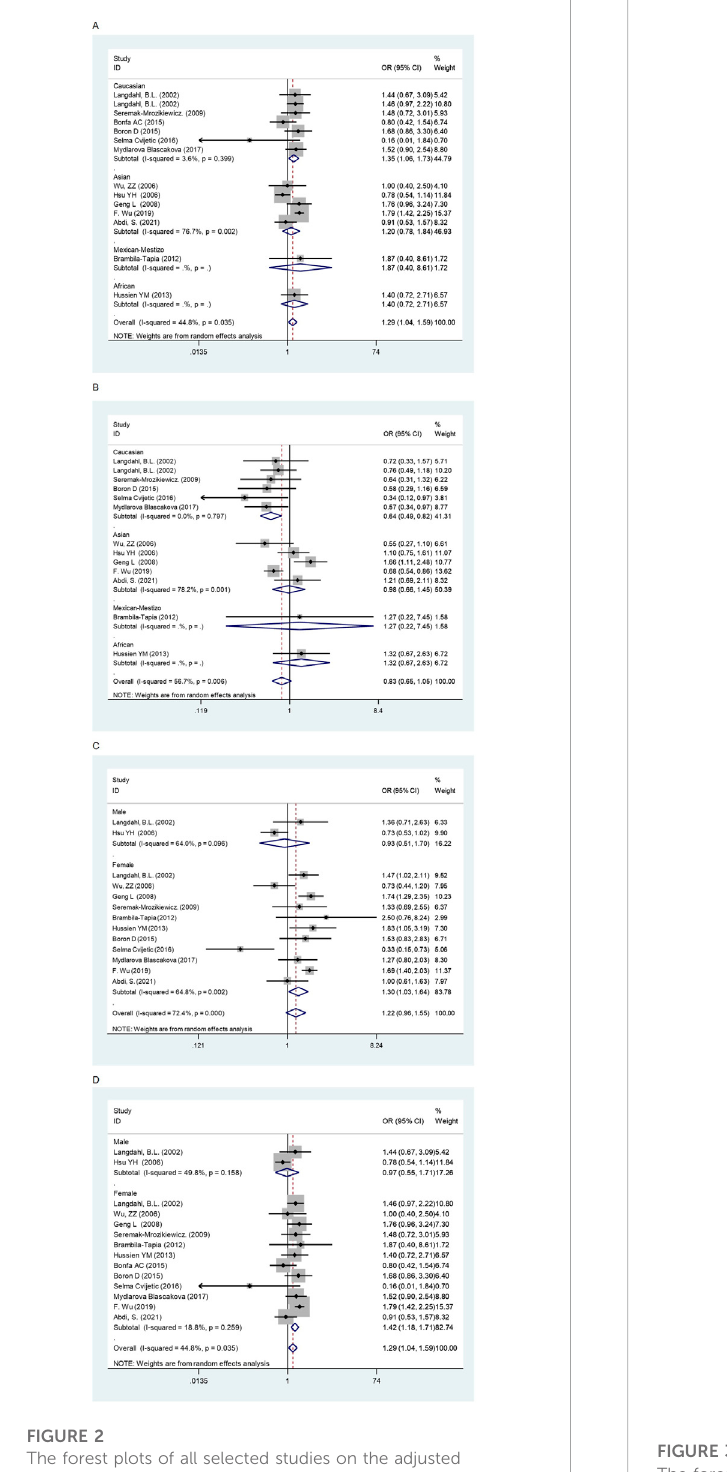
FIGURE 3 The forest plots of all selected studies on the adjusted association between the OPG G1181C polymorphism and risk of osteoporosis in overall and subgroup analyses by ethnicity and sex (A:CvsG; (B) CCvsGG; (C) GC+CCvsGG; (D) CvsG; (E) CC vs GG; (F) GC + CC vs GG; (G) CC vs GG +